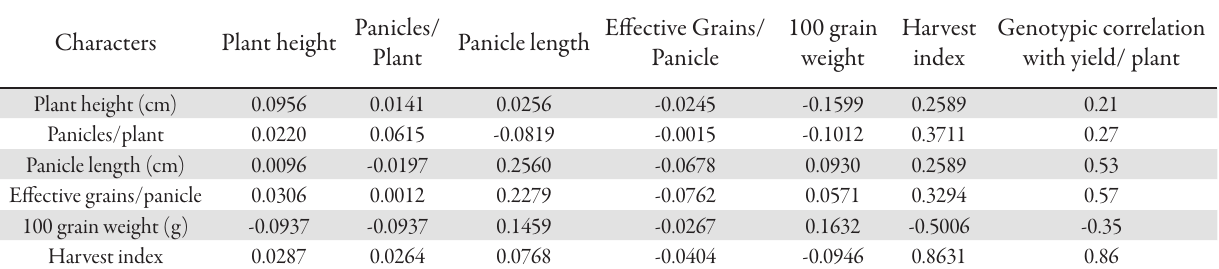
Tab. 3. Direct (diagonal values) and indirect effects of different characters on yield/plant at genotypic